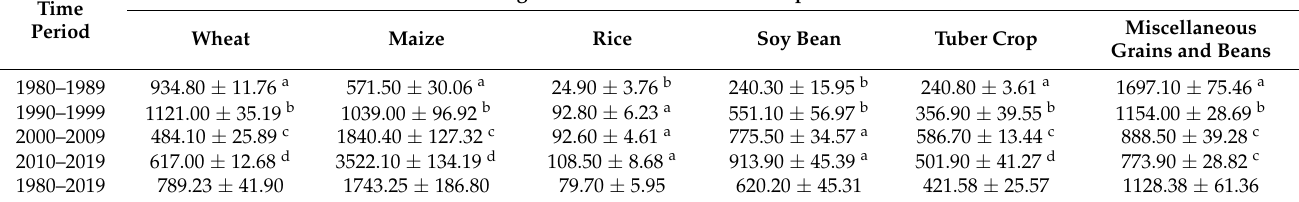
Table 1. Sown area of different crop varieties of Inner Mongolia Autonomous Region from 1980 to 2019.